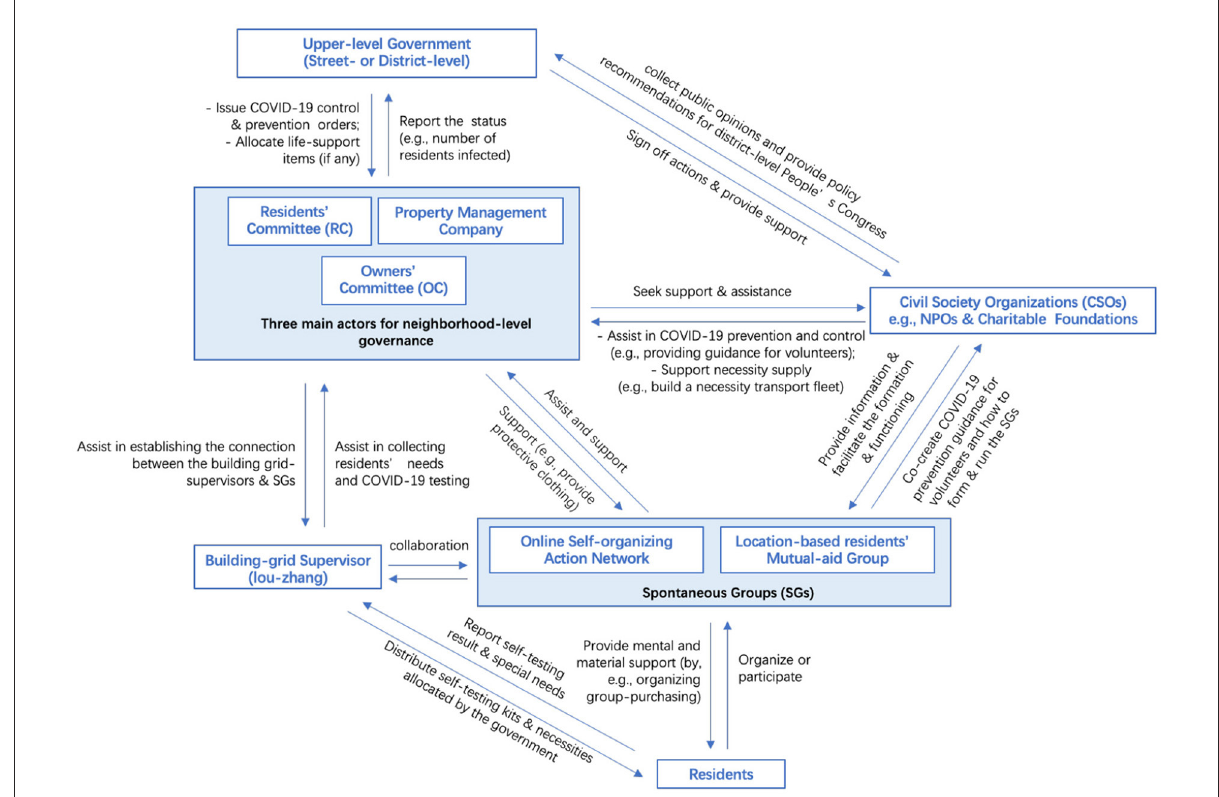
FIGURE2 The network of community governance in Shanghai during COVID-19